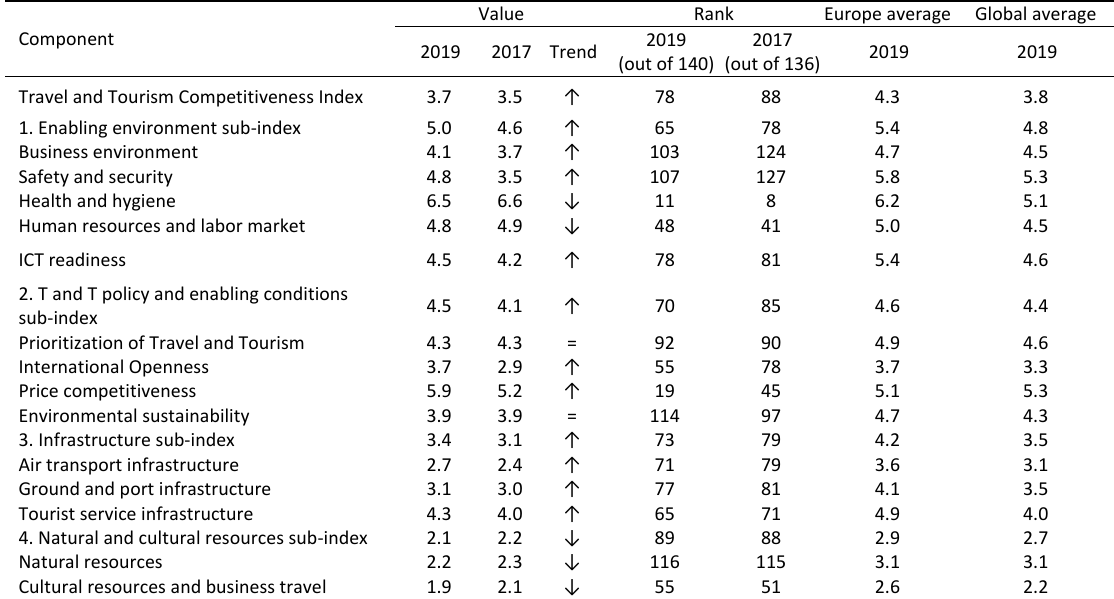
Table 1: Ukraine profile in the travel and tourism competitiveness index report (TTCR, 2017; TTCR, 2019) Component